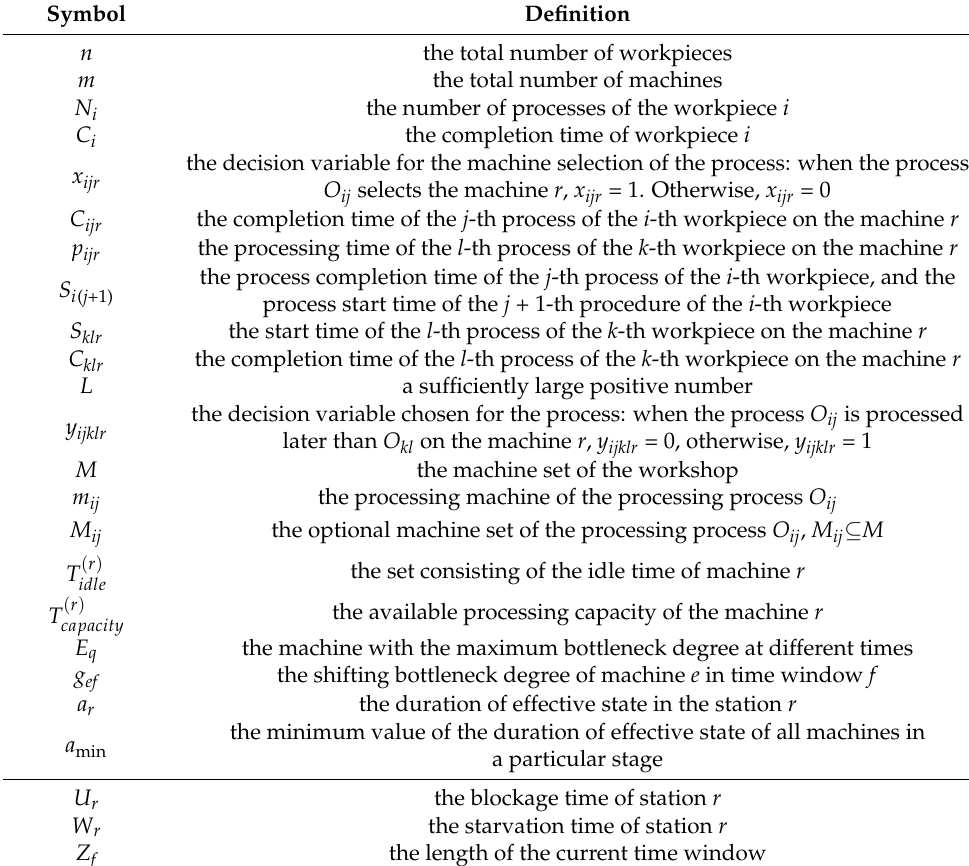
Table 1. The symbols involved in the mathematical model and their